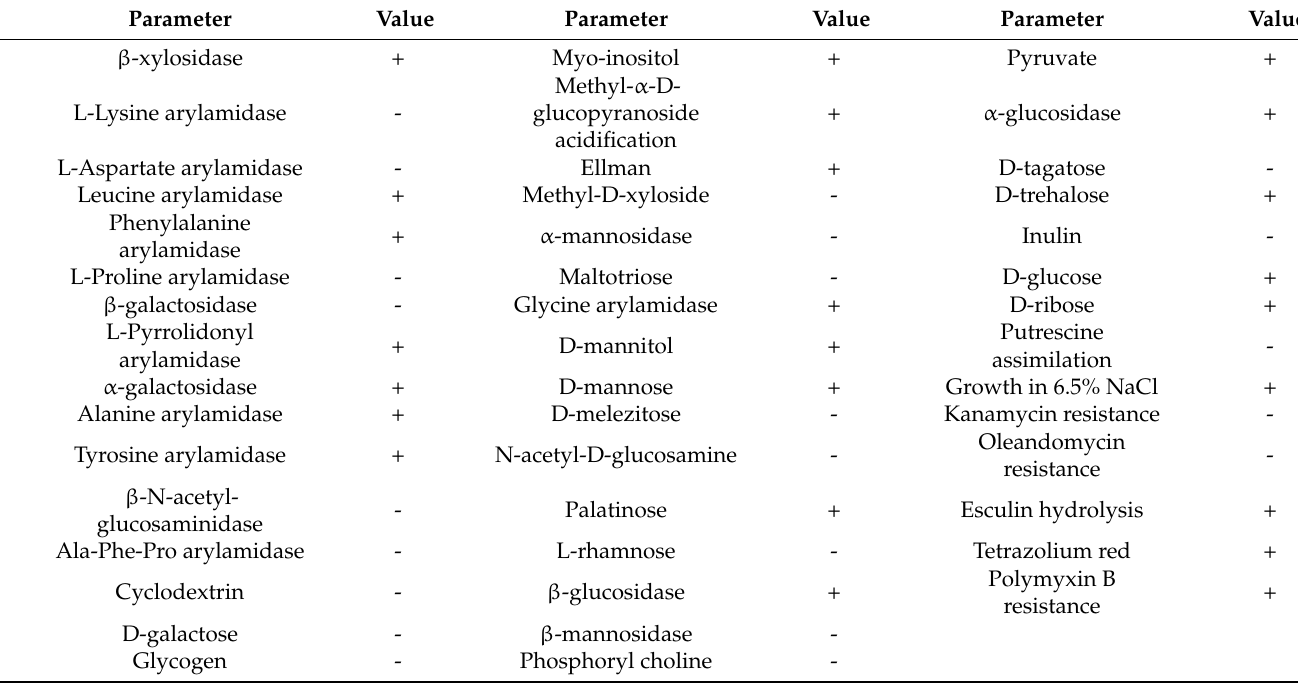
Table 2. The results of the VITEK2 biochemical tests for the producing microorganism Bacillus sp. BioSol021.